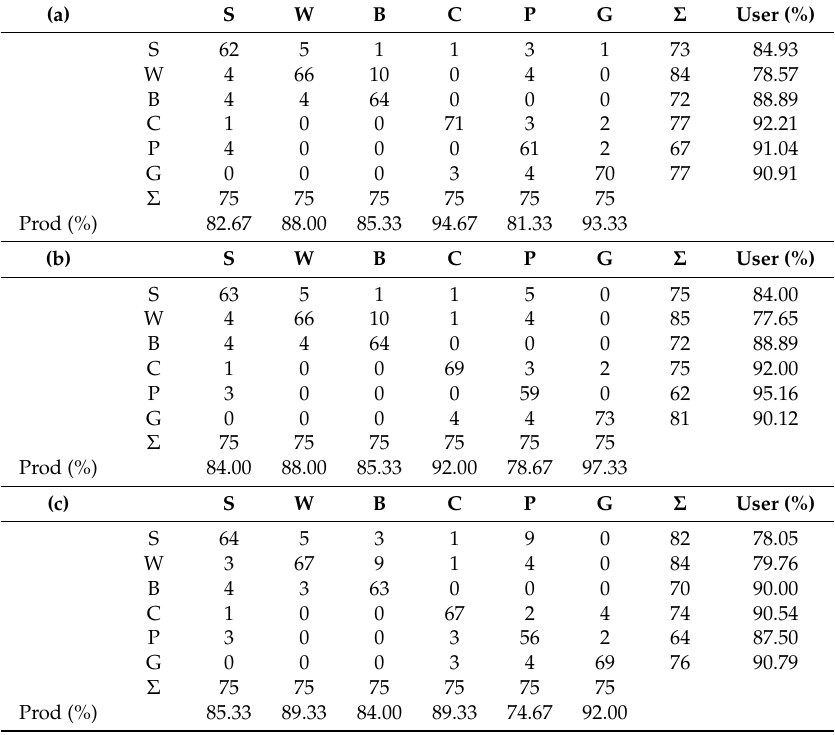
Table 7. Confusion matrices for classifications by the RVM using training sets containing cases mislabelled to a randomly selected class: ( a ) 5% error; ( b ) 10% error; and ( c ) 20% error.